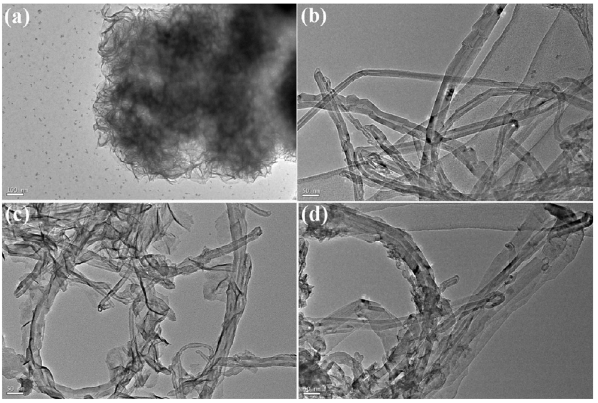
Fig. 3 TEM images of (a) MoS 2 , (b) MWCNTs, (c) MoS 2 - MWCNT-1, and (d) MoS 2